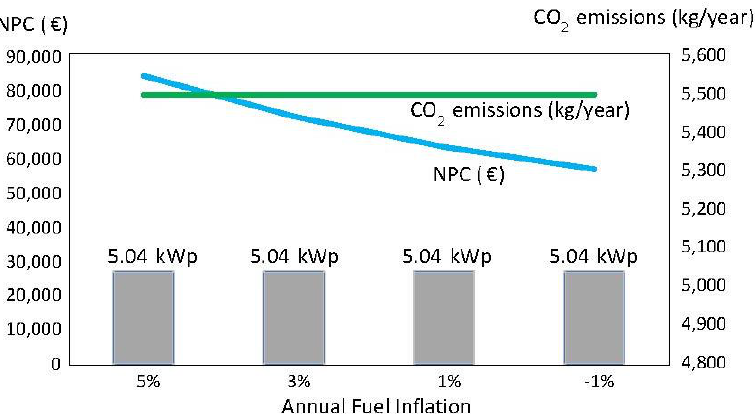
Figure 6. PV + Diesel systems. Optimal solutions include cases with a PV cost of 0.55 €/Wp.